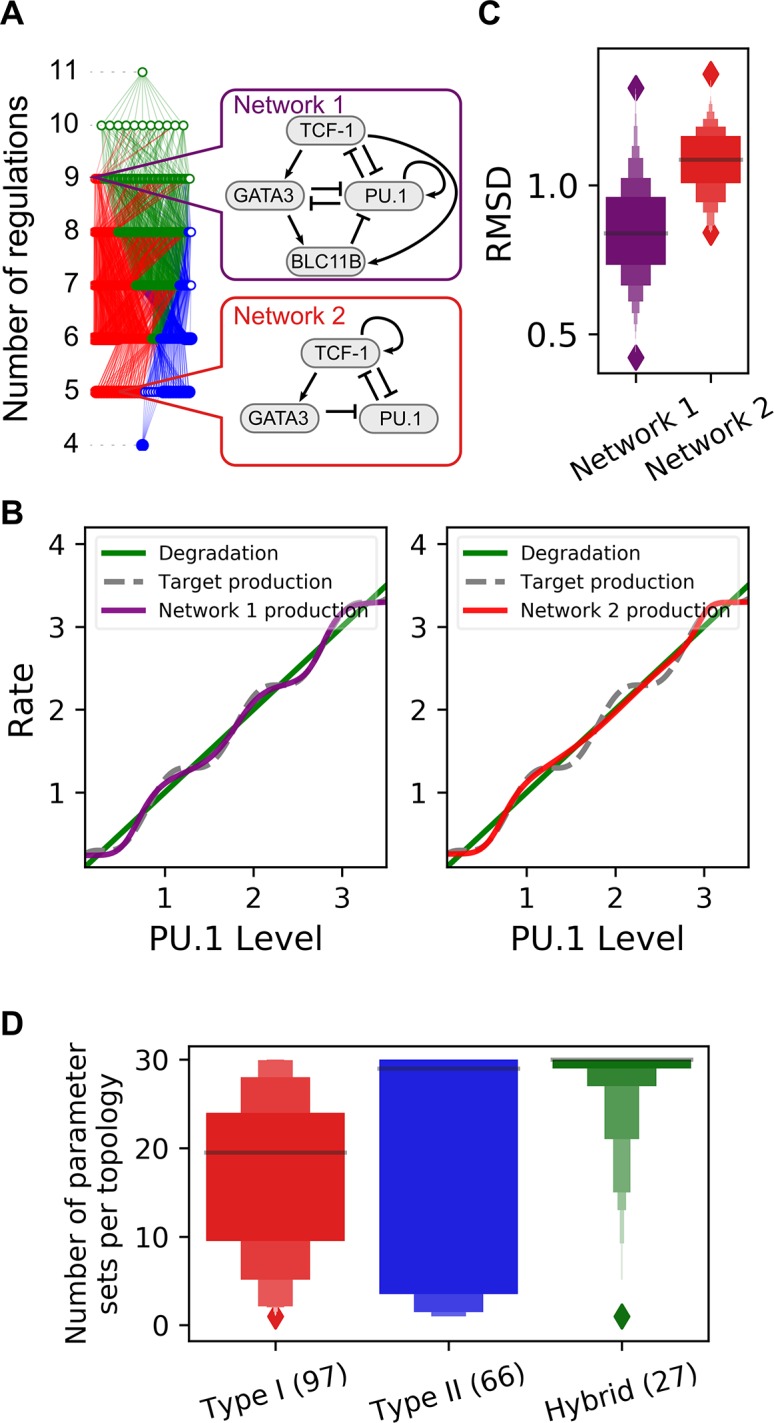
Comparisons of motifs with different complexity and types.A. Two specific network topologies were selected for comparing models with different complexity. Network 1 contains multiple Type I motifs, whereas Network 2 is a single Type I motif. The color code of the complexity atlas is the same as that in Fig 2 and Fig 4. Red: Type I motif. Blue: Type II motif. Green: Hybrid motif. B. Performances of the two subnetworks are compared. Performance was quantified with the sum of squared distance (SSD) from a predefined hypothetical continuous production function (gray curve) of PU.1 level that have 7 intersections with the degradation function, which generates four attractors (see details in supplementary text). The purple and red curves represent the optimized functions fitted to the gray curve. The gray curve is closer to the purple curve than to the red curve, suggesting a better fit with Network 1. C. SSD values obtained from 500 optimization runs for each of Network 1 and Network 2. Each value was calculated using the procedure shown in B. D. Numbers of parameter sets that generate the four-attractor systems per 106 random samples per topology. Three types of network motifs with 7 regulations are compared.